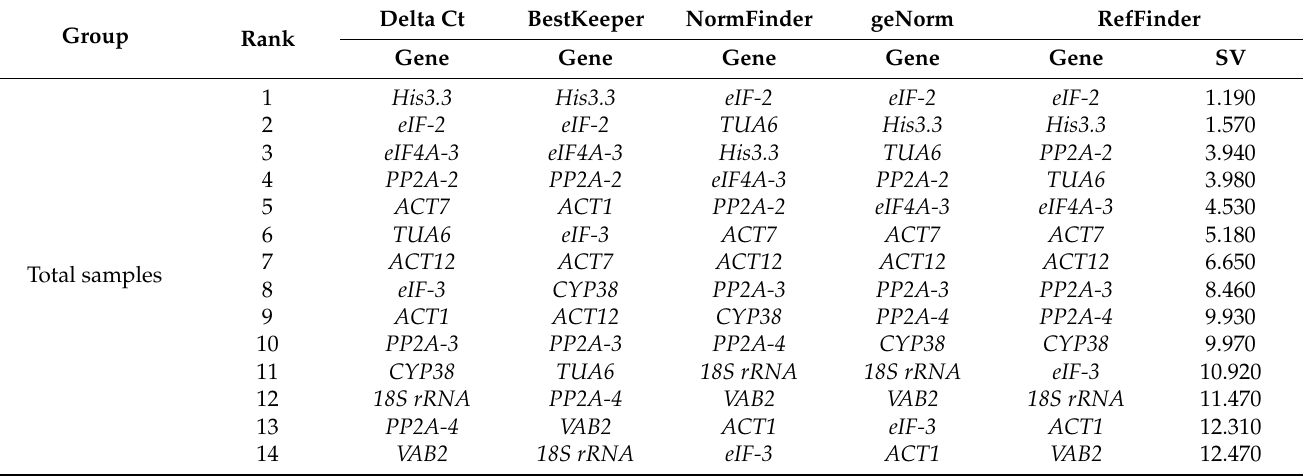
Table 3. Comprehensive evaluation of expression stability of fourteen candidate reference genes in P. vulgaris using the RefFinder